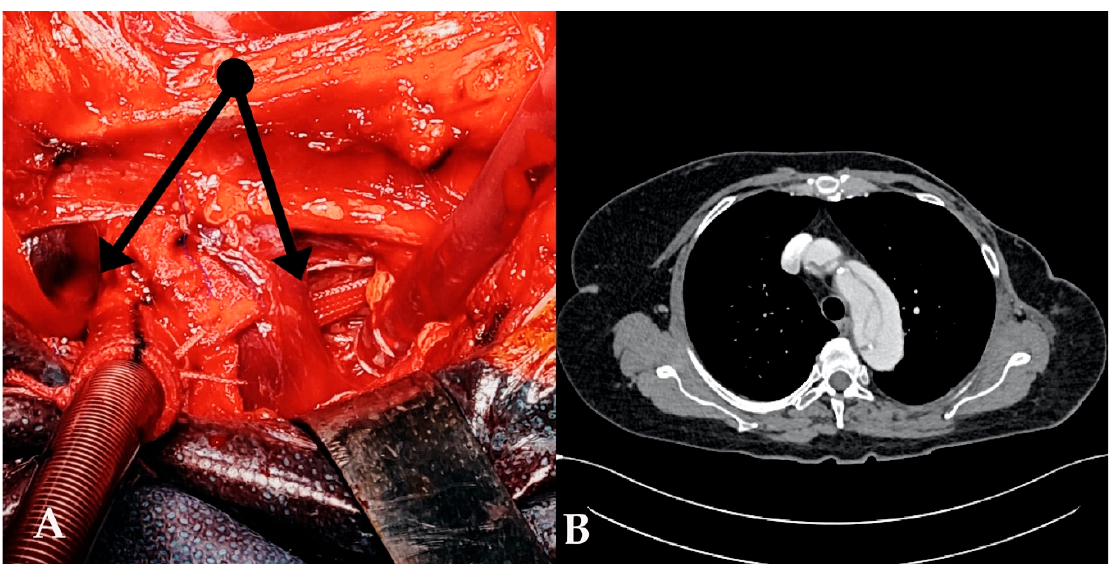
Figure 1. Cannulation of innominate artery ( A , arrows) in extreme case with completely compressed true lumen. ( B , see Video S1). An 8 mm Dacron graft was anastomosed to the medial side of the artery using a Te fl on felt-reinforced polypropylene 5-0 suture.